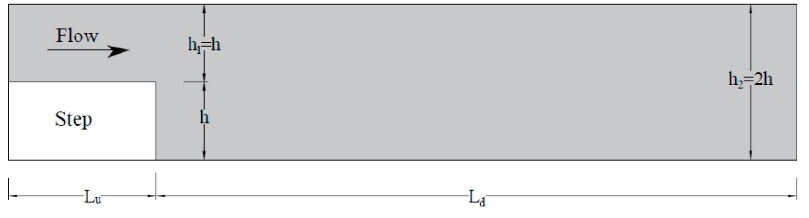
Figure 1. Flowchart of the numerical modeling procedures.